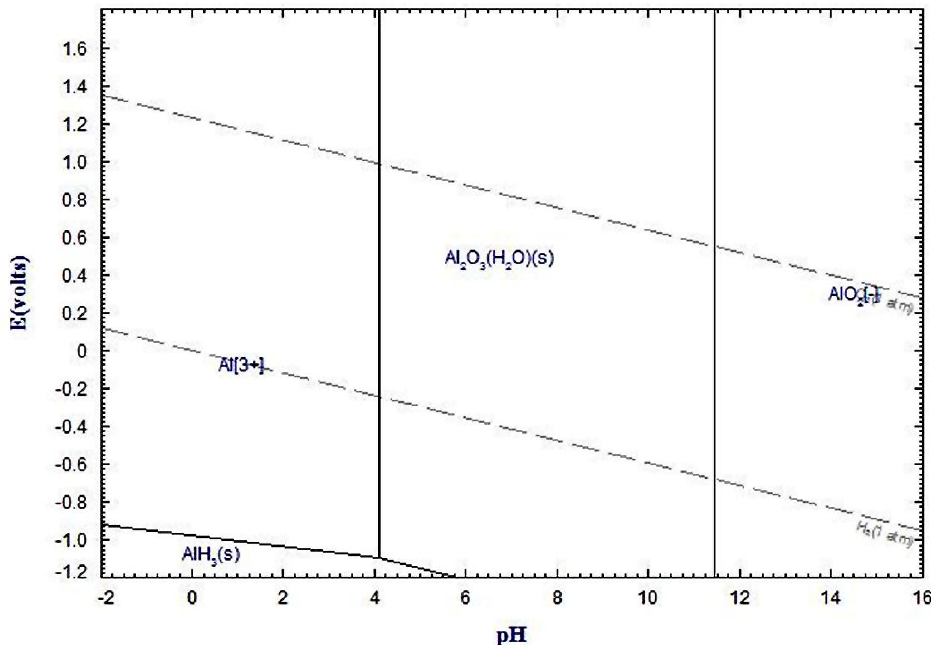
Figure 1. Pourbaix or potential-pH diagram of Al in aqueous environment, calculated for a temperature of 300 K and a molality of 1e −6 mol/kg